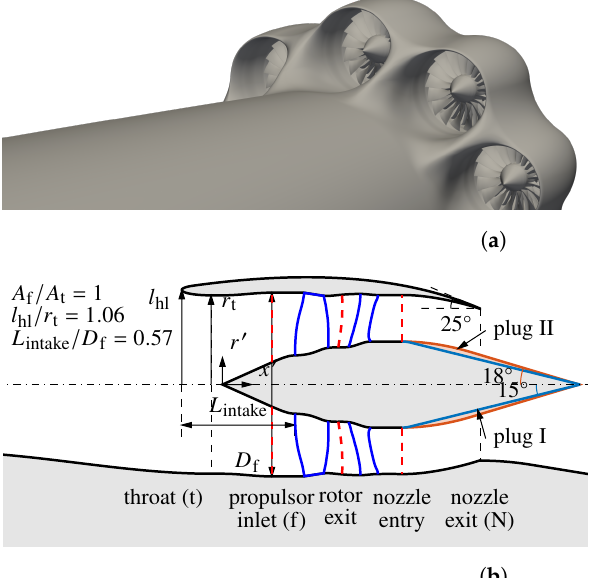
Figure 4. Details of the installation. ( a ) 3D view. ( b ) Propulsor meridional view showing the two different nozzle plugs for cases I and